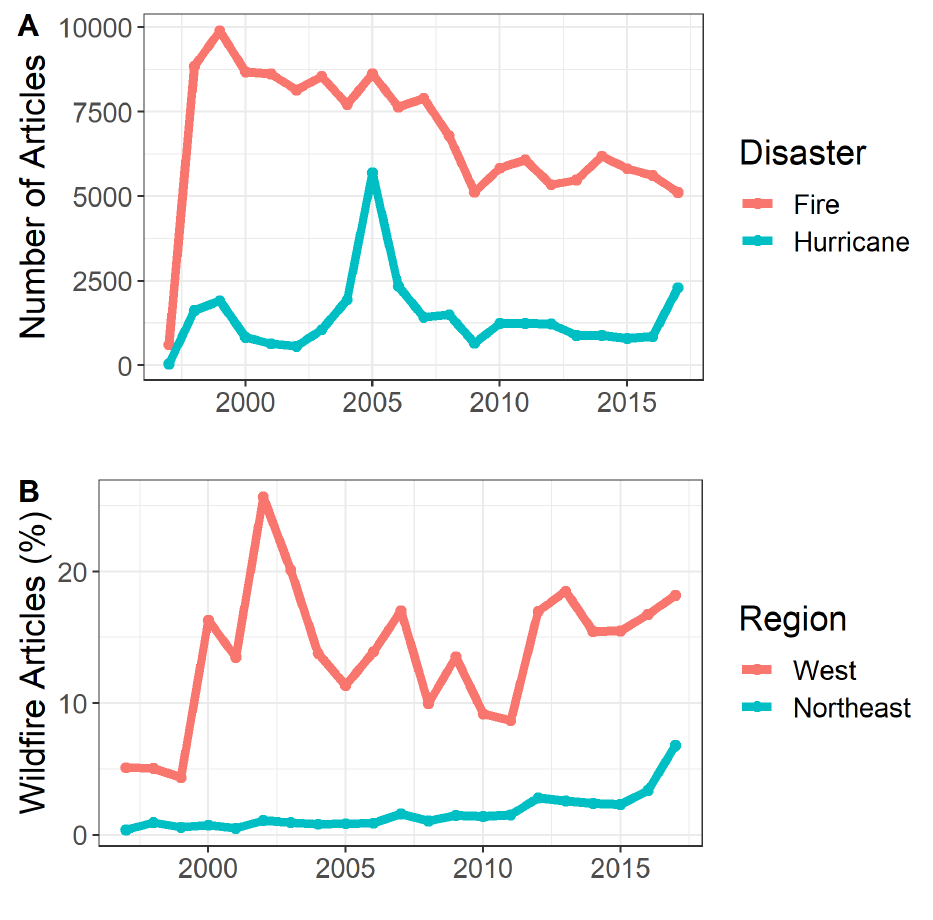
Figure 3. Annual Disaster Coverage Over Time. More articles were published for fires than hurricanes ( A ), while regional variations in coverage are observed in wildfire-related coverage (as a percentage of fire articles) ( B